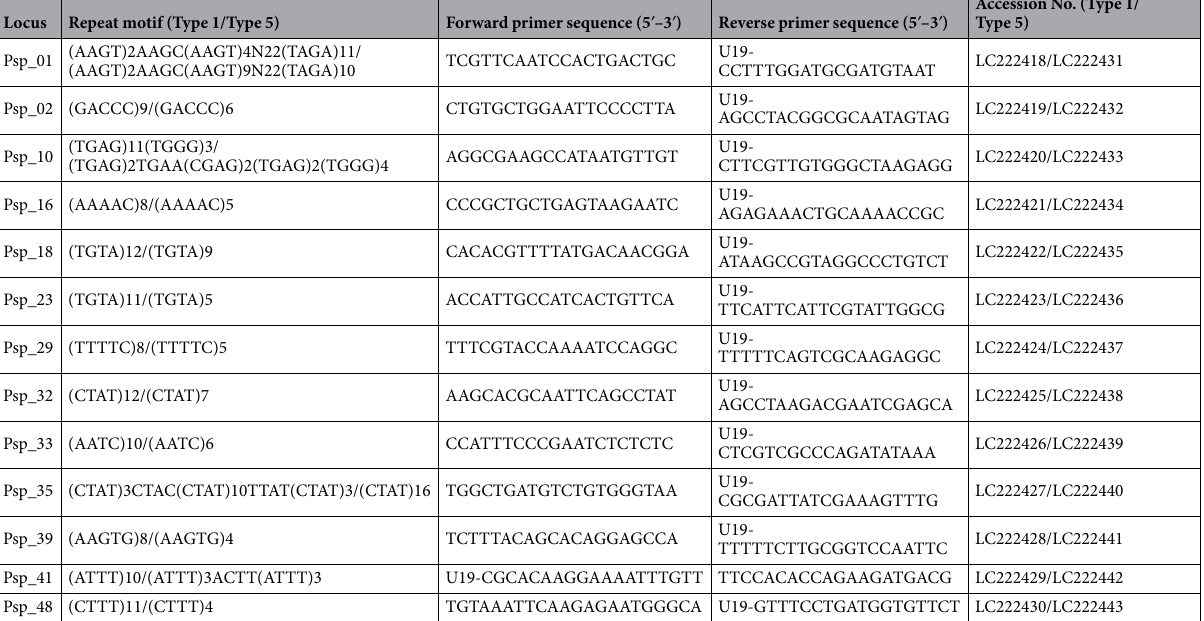
Table 1. Characteristics of novel microsatellite loci developed for Pocillopora in this study: locus name, repeat motif, forward and reverse primer sequences, and GenBank accession number for each lineage used for isolation of genomic